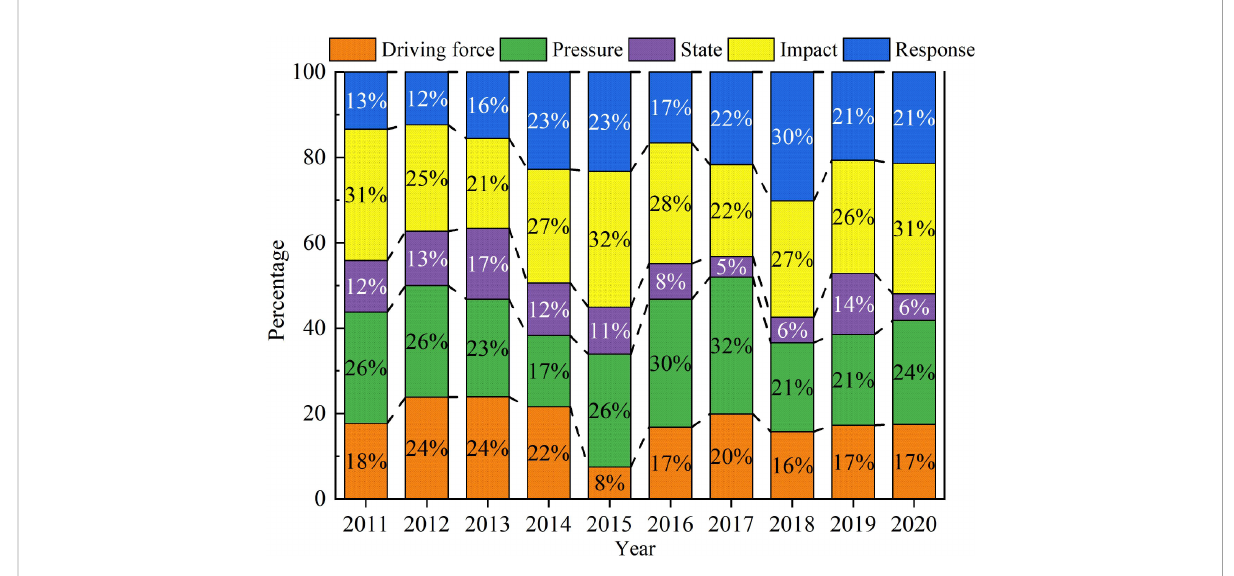
FIGURE 3 Percentage of each indicator (DPSIR) of the coastal zone ecological safety evaluation system in